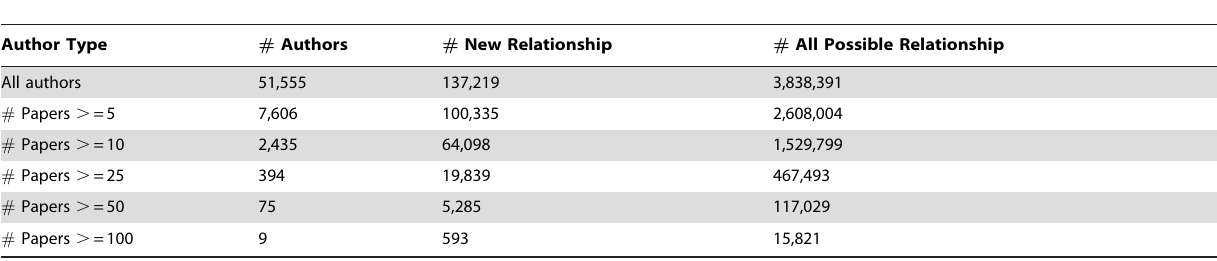
Table 2. The summarization of the author sets with different productivity.